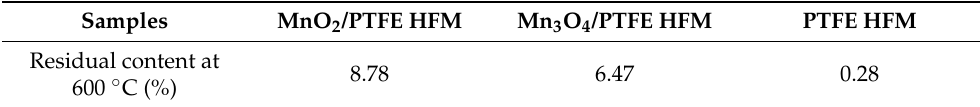
Table 3. Manganese oxide content in the PTFE HFMs.